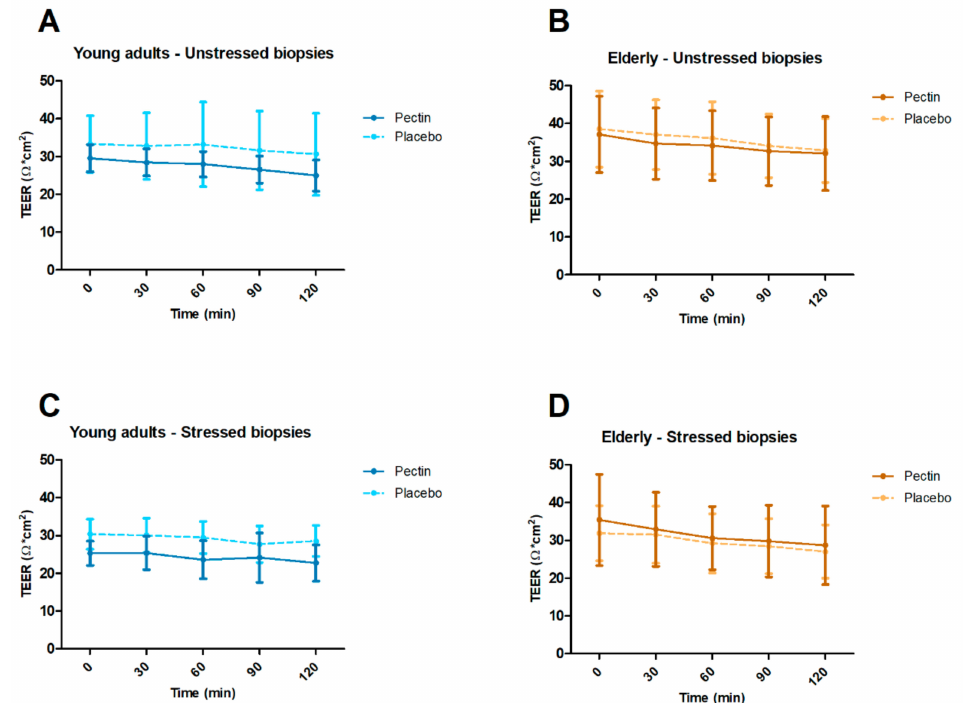
Figure 5. Intestinal permeability ex vivo after four weeks of pectin (fixed lines) and placebo (dashed lines) intervention in young adults and elderly. Analyses were conducted by mounting fresh sigmoid biopsies in an Ussing chamber system and assessing transepithelial electrical resistance (TEER) at t = 0, 30, 60, 90, and 120 min. ( A ) TEER in young adults in unstressed biopsies. ( B ) TEER in elderly in unstressed biopsies. ( C ) TEER in young adults in biopsies stressed by 1 µ g / mL Compound 48 / 80 at t = 0. ( D ) TEER in elderly in biopsies stressed by 1 µ g / mL Compound 48 / 80 at t = 0. Means and standard deviations are shown. Sample sizes varied because baseline values of some sigmoid biopsies did not meet quality criteria for viability. Within age groups, TEER and luminal fluorescein were compared between intervention groups with random intercept linear mixed models and correction for baseline values. p -values per time point were corrected for multiple testing by calculating the false discovery rate (FDR) of